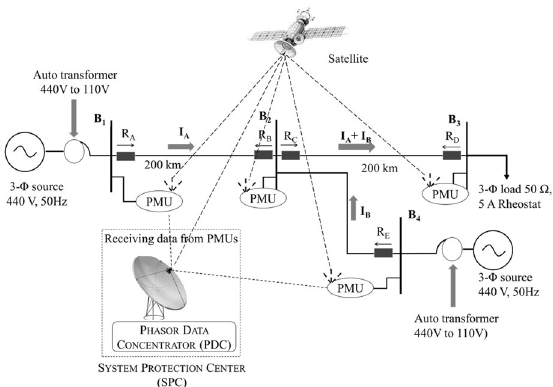
Fig. 9 Single line diagram of the scale down laboratory model of EHV MTL system for infeed condition